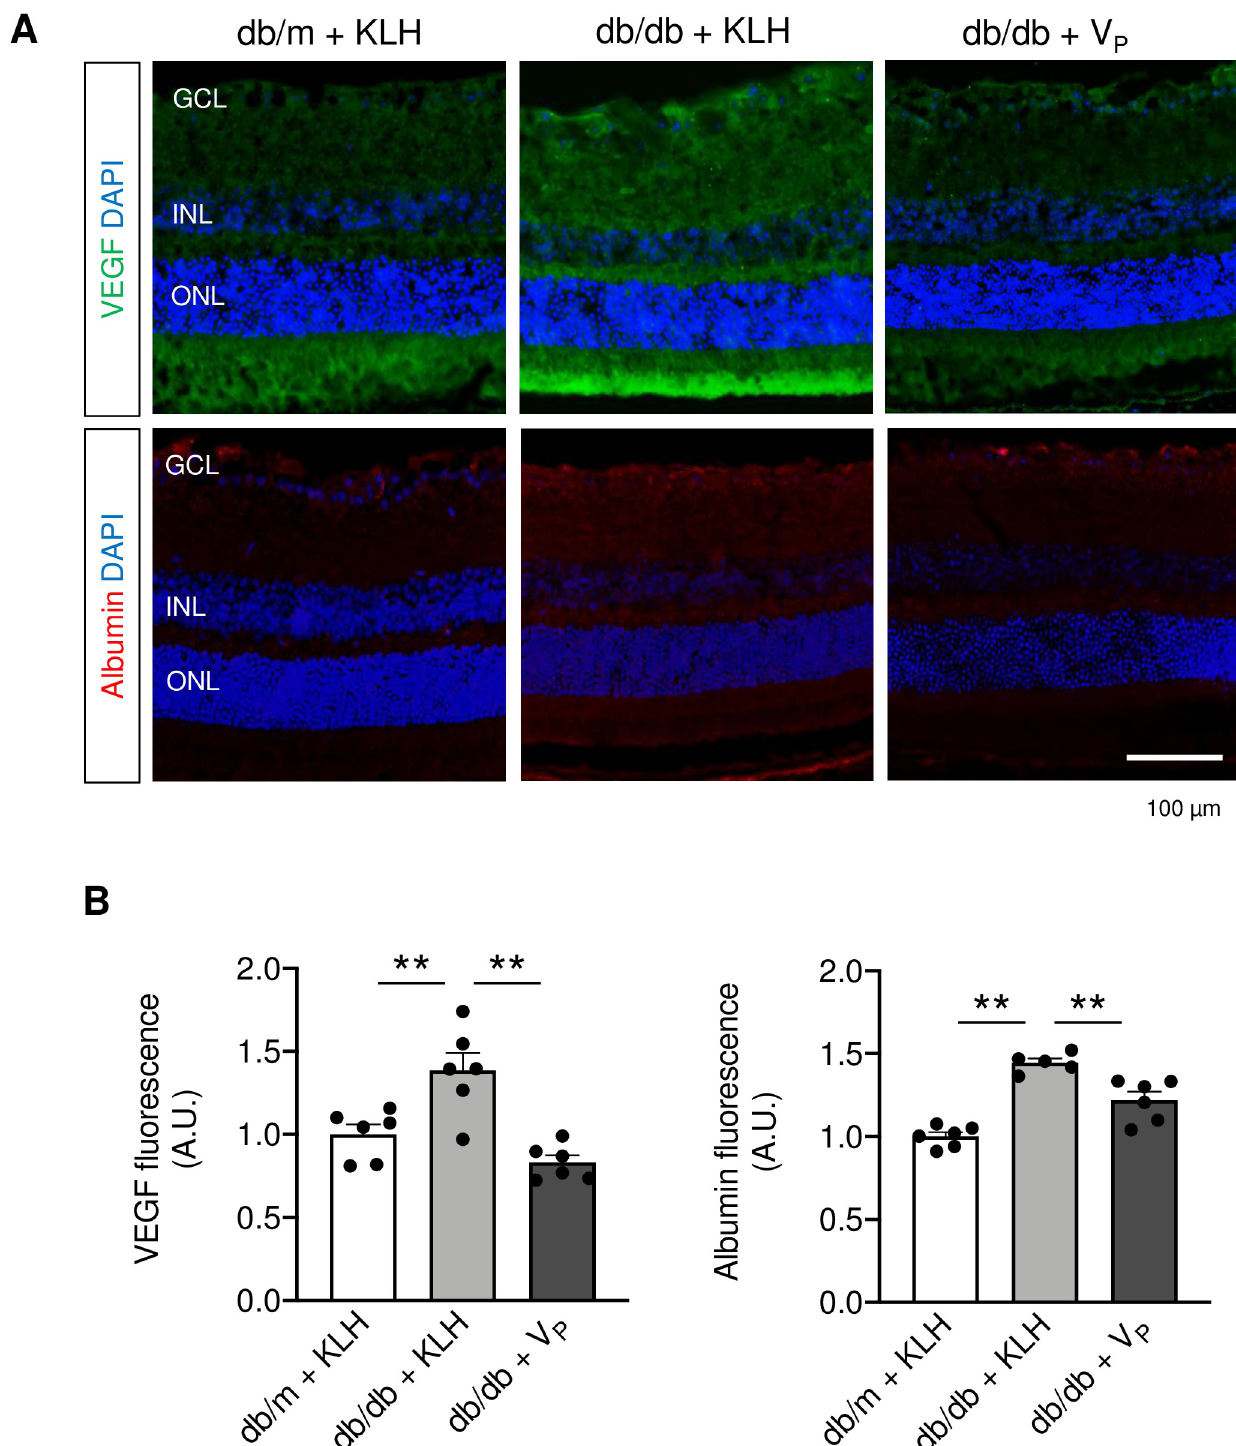
Fig 7. Immunohistochemical analysis of vascular leakage in the retina of mice at 24 weeks of age. (A) Vascular endothelial growth factor (VEGF; green), and albumin (red) for vascular leakage in the retina. (B) Quantification of VEGF expression and albumin in the retina. �� p < 0.01. DAPI, 4 0 ,6-diamidino-2-phenylindole; GCL, ganglion cell layer; iba-1, ionized calcium-binding adapter molecule 1; INL, inner nuclear layer; KLH, keyhole limpet hemocyanin; ONL, outer nuclear layer; VEGF, vascular endothelial growth factor; V P , prorenin peptide vaccine. Scale bar = 100 μ m.